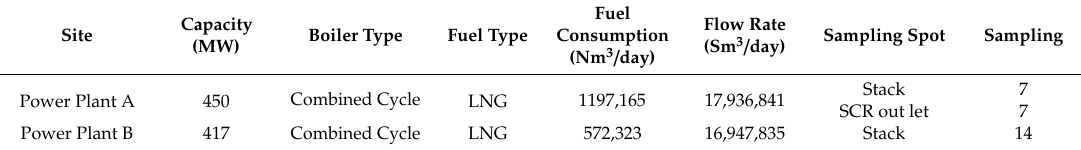
Table 1. Characteristics of the investigated bituminous coal power plant.